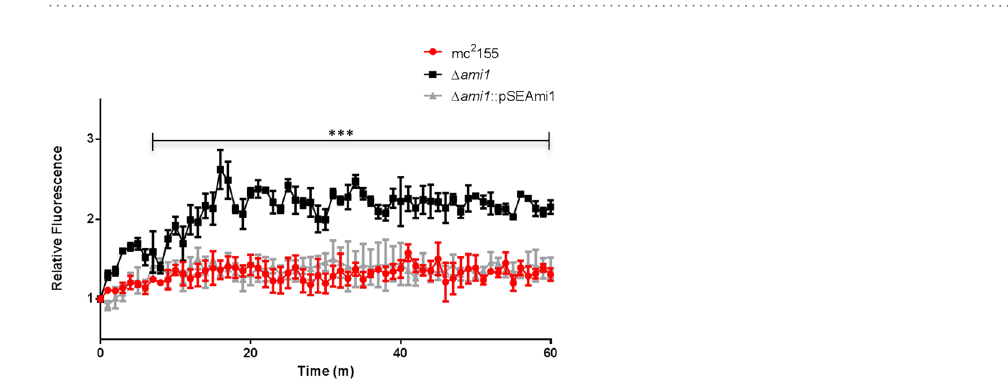
Table 1. Drug susceptibility of the Δ ami1 mutant. * MIC in µ g/mL, § fold increase in susceptibility over wild type is given in parenthesis.